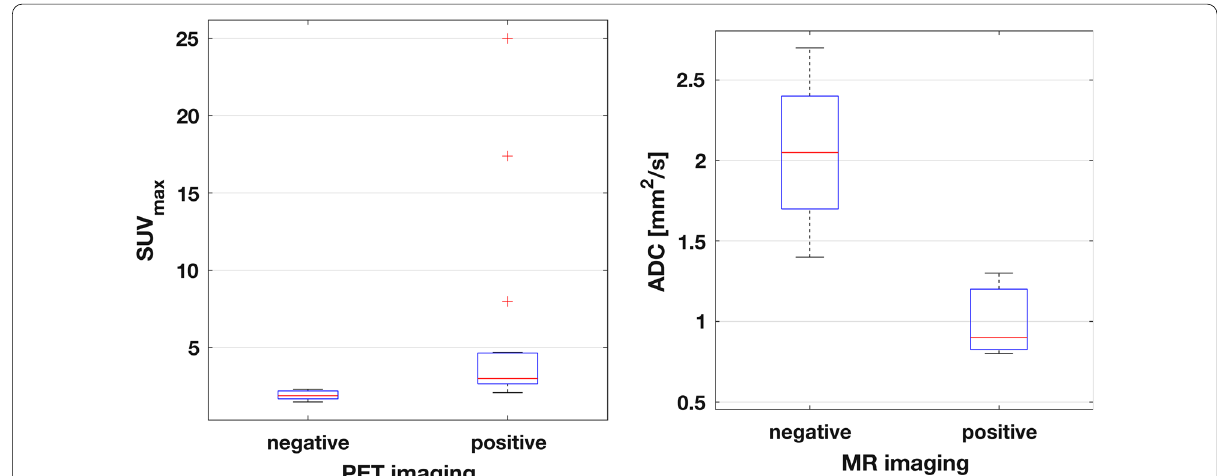
Fig. 1 Box and whisker plots of SUV max values derived from PET and ADC values derived from DWIBS. The red plus sign is the outlier. The results are reported in Table 3